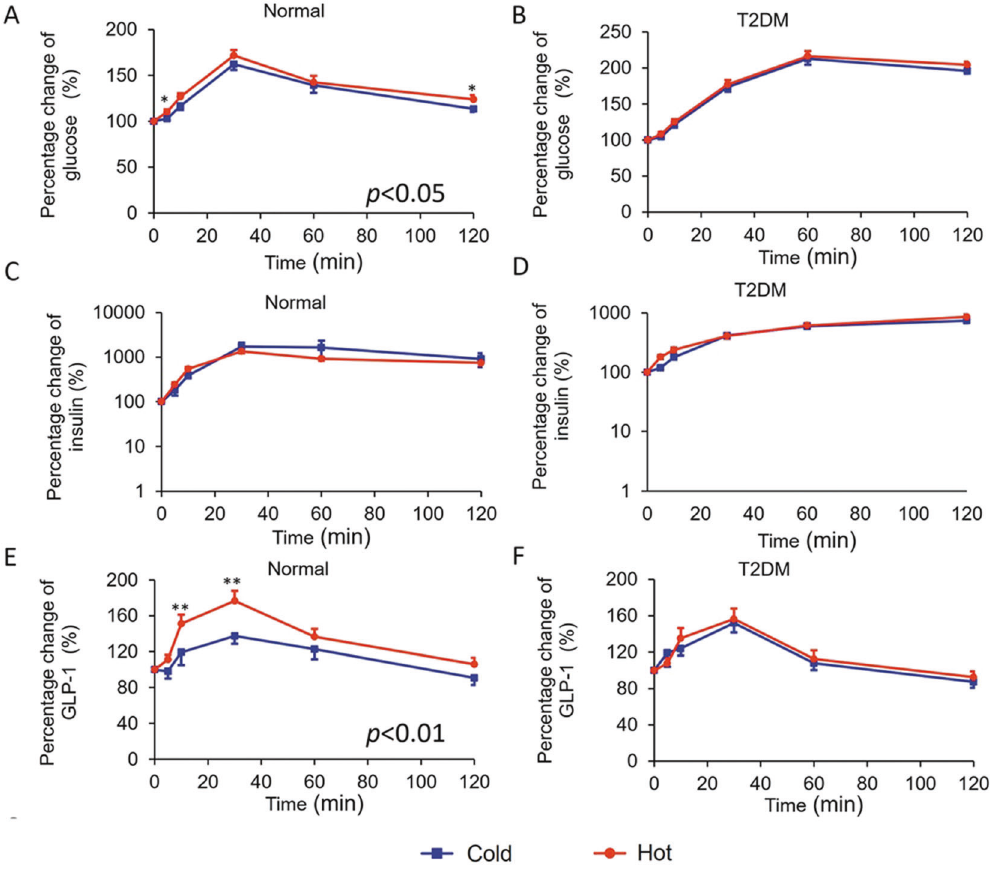
Fig. 3 Percentage change of blood glucose and glucose-responsive hormones in cold and hot OGTTs. Percentage changes from the baseline of OGTT were also calculated as follows: values at each time point/values at baseline × 100%). The percentage change of blood glucose ( A , B ), insulin ( C , D ), and GLP-1 ( E , F ) with OGTTs in normal ( n = 19) and T2DM ( n = 22) groups. Data were analyzed with ANOVA for repeated measurements. If there was statistical signi fi cance between the two temperatures ( P < 0.05 ANOVA), this was followed with a Bonferroni test for speci fi c time points. Blue line = cold OGTT; red line = hot OGTT; * P < 0.05 in Bonferroni test. OGTT oral glucose-tolerance test, GLP-1 glucagon-like peptide-1, T2DM type 2 diabetes mellitus.